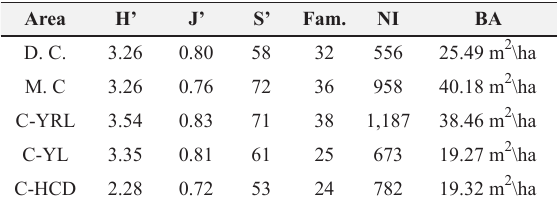
Data from the analysis of the vegetation structure in the FLONA of Paraopeba, MG, Brazil.